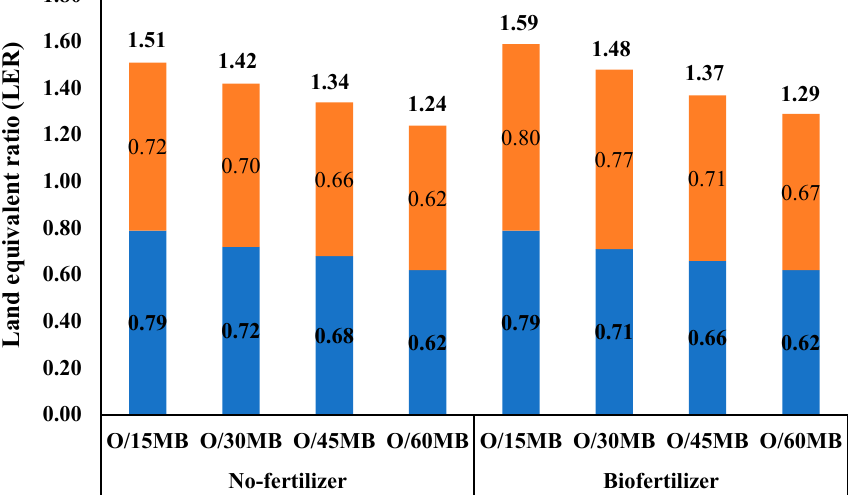
Figure 8. The land equivalent ratio (LER) index of different intercropping patterns along with application and non ‐ application of biofertilizer.